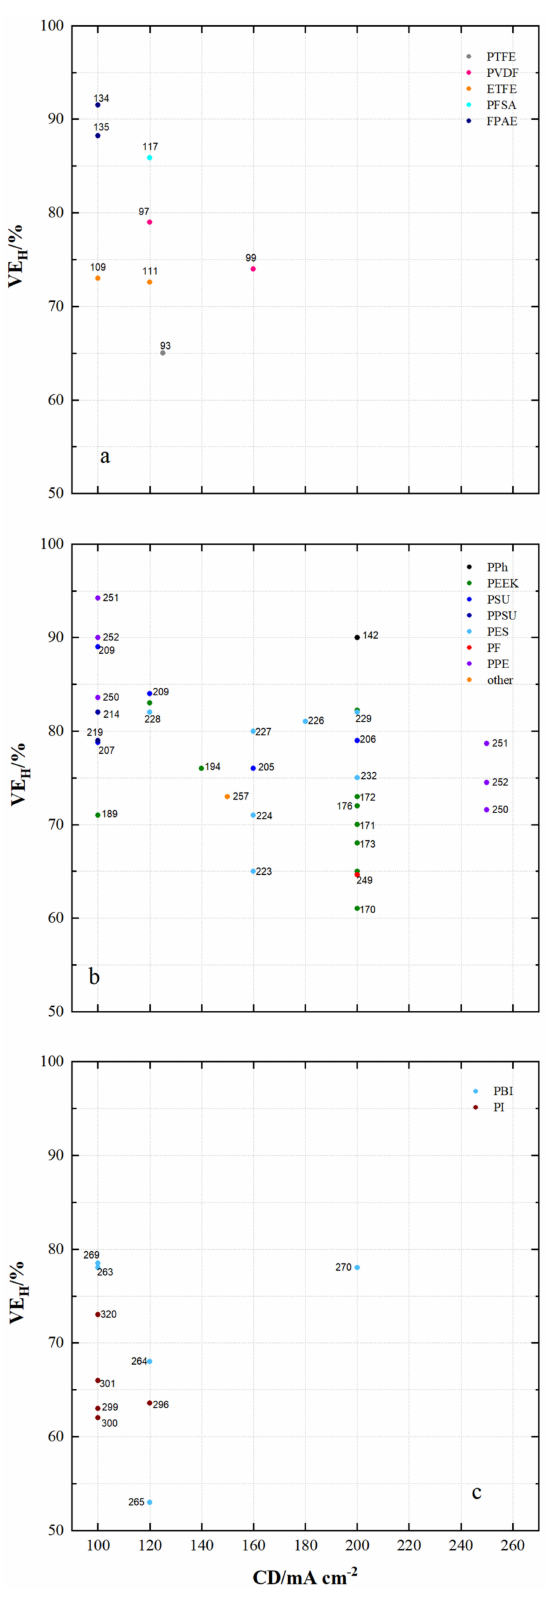
Figure 13. The voltage efficiency of VRFB cells by using membrane samples at current densities ≥ 100 mA cm − 2 : ( a ) fluoro-carbons, ( b ) hydro-carbons and ( c ) N